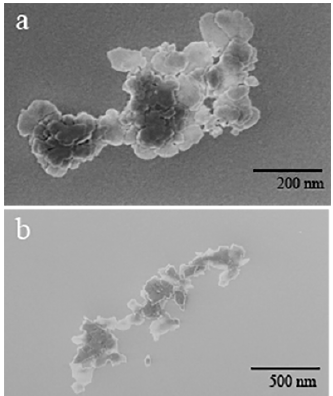
Figure 1. SEM images of ( a ) commercial MgO nanoparticles and ( b ) 2000 rpm pellet of ball-milled MgO nanoparticles. The samples were deposited on strong carbon grids and the electron beam was accelerated with 500 kV.